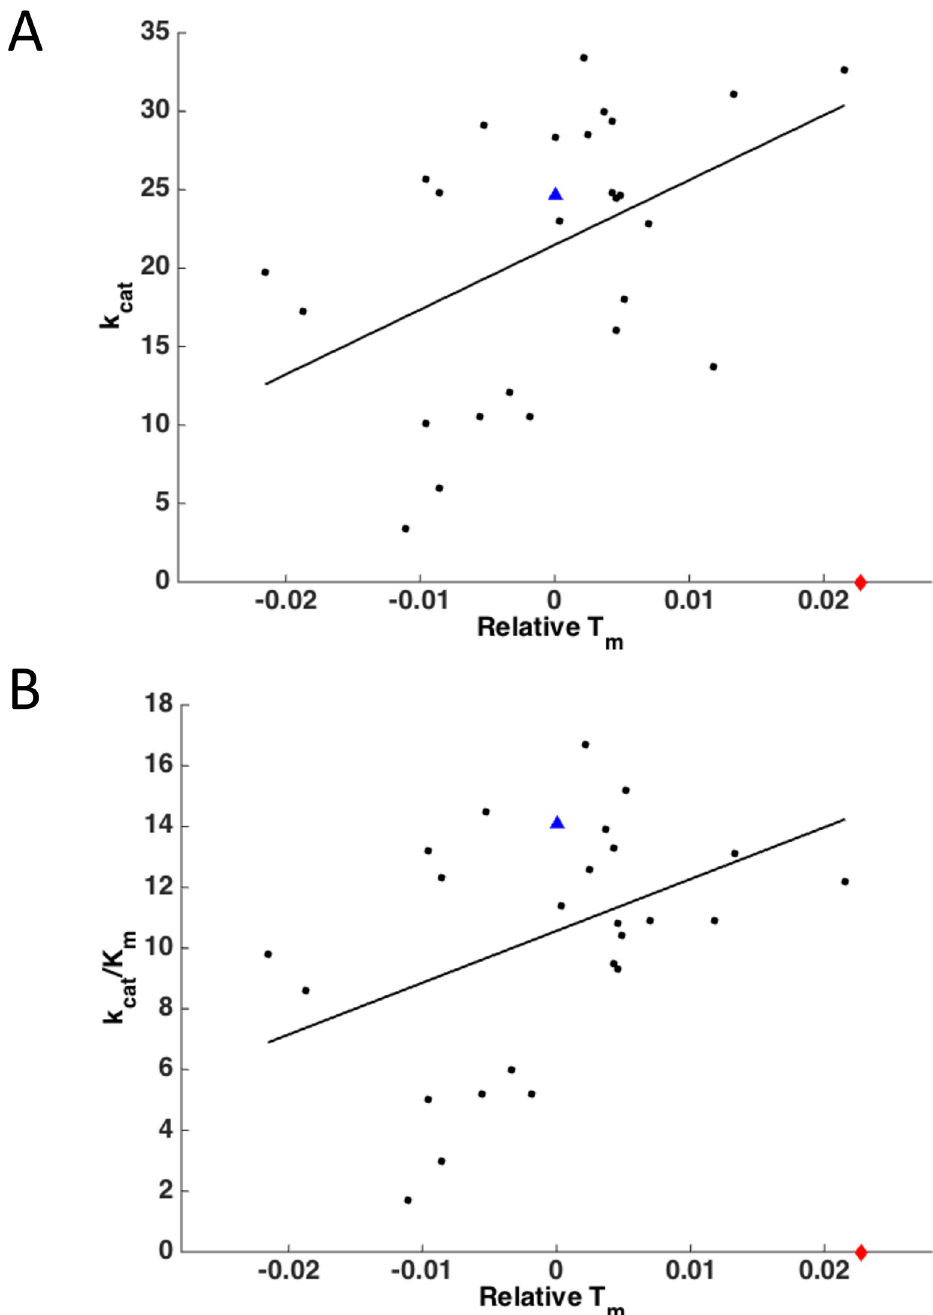
Fig 9. Correlation between DHFR activity and stability. WT is shown as a blue triangle; D27F is shown as a red diamond at zero activity. (A) Plot of k cat vs. experimental relative T m . r = 0.46, p = 0.02 (excluding outlier D27F). (B) Plot of k cat / K m vs. experimental relative T m . r = 0.41, p = 0.03 (excluding outlier